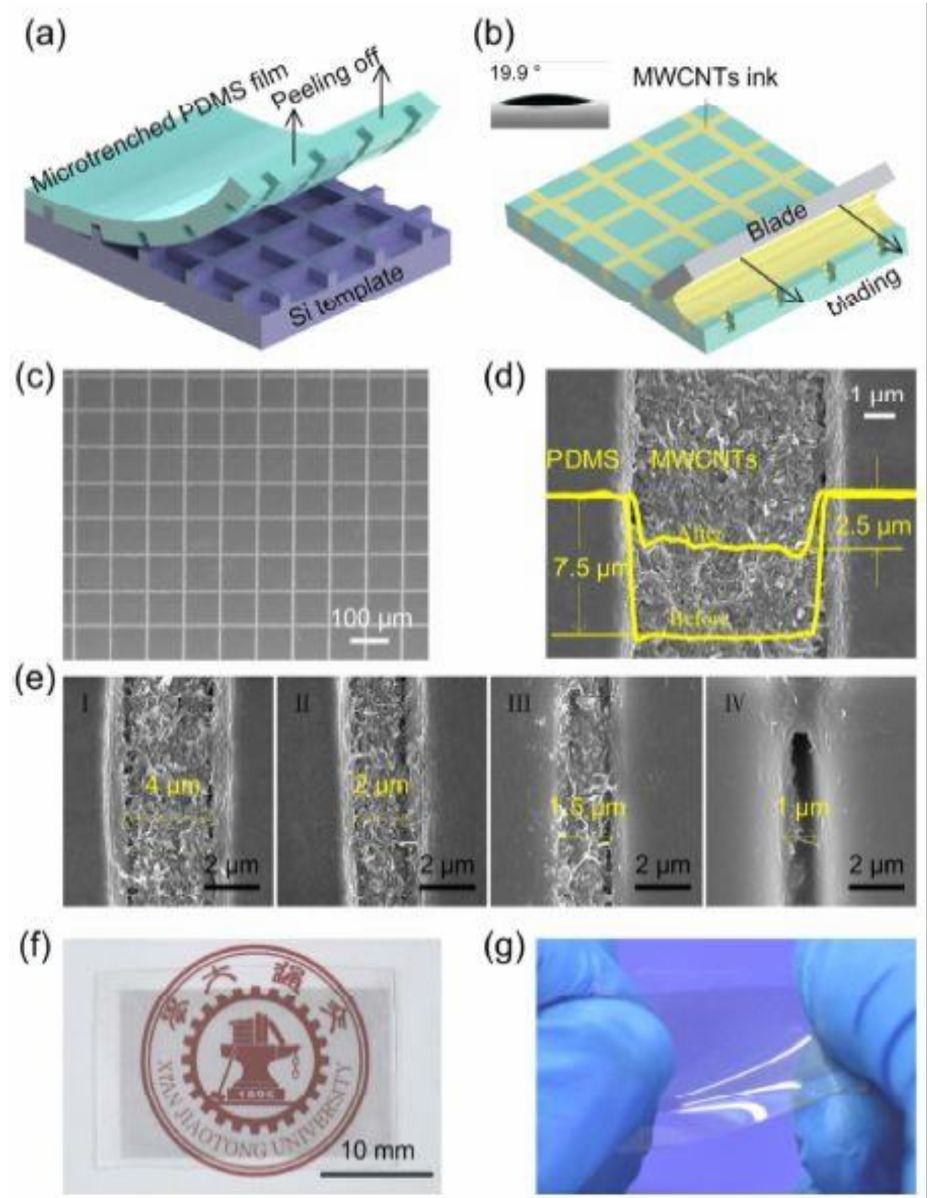
Figure 2. ( a , b ) Fabrication process of the multi-walled carbon nanotube (MWCNT)-based sensors formed using flexible PDMS films having mesh-like microtrenches. ( c ) Scanning electron microscope (SEM) images of the developed sensors with MWCNTs embedded in the microtrenches. ( d ) Profiling of the microtrenches before and after the embedding process. The formed sensors were kept in ( e ) normal, ( f ) weisting positions and ( g ) Representation of high stretchability of the sensors. [74]. Reproduced from Nie, B.; Li, X.; Shao, J.; Li, X.; Tian, H.; Wang, D.; Zhang, Q.; Lu, B. Flexible